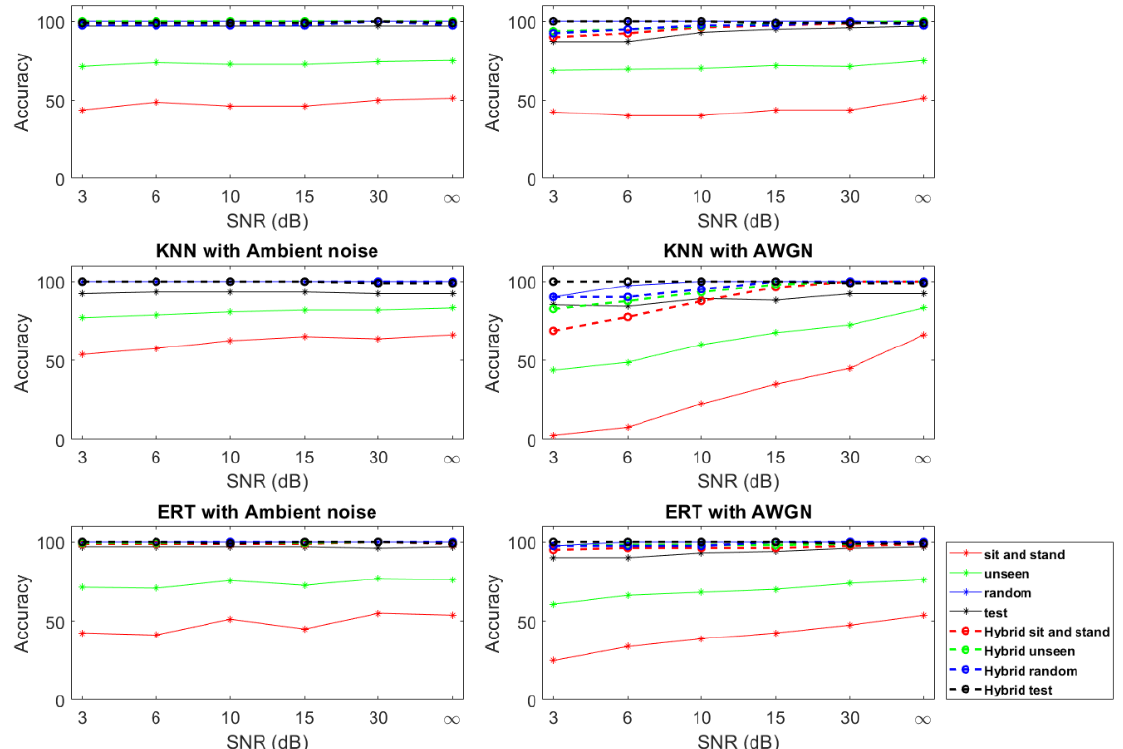
Figure 8. Effect of ambient noise and AWGN on performance of the acoustic-based and hybrid-based HAR system. Different SNR levels are included for each kind of noise. Accuracy of acoustic and hybrid systems with SVM, KNN, and ERT are shown. Dashed lines correspond to the performance of the hybrid system. Sit and stand, unseen, random, and test refer to the corresponding datasets used for evaluation.